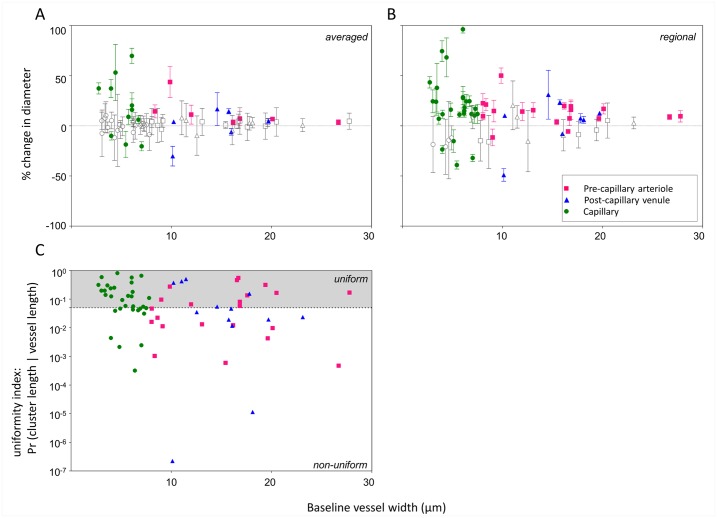
Relative responses and uniformity indices for vessels according to size.(A) Average response for each segment (B) largest regional response for each segment for all 67 segments post-flicker. Data is expressed as the percentage change from baseline diameter (y-axis) as a function of baseline vessel size (x-axis). Error bars are 2 SEM values for each segment. Coloured symbols represent segments that displayed a definite response defined as “responses” whose 95% confidence intervals do not encompass zero. Grey symbols represent segments classified as “non-responders” where the 95% confidence interval encompasses zero. (C) Uniformity index for all segments studied, i.e. the y-ordinate plots the probability of the observed pattern if apparent non-uniformities are caused by chance. Segments with data points below the dotted line (p = 0.05) are taken as demonstrating locality (non-uniformity) in their response.